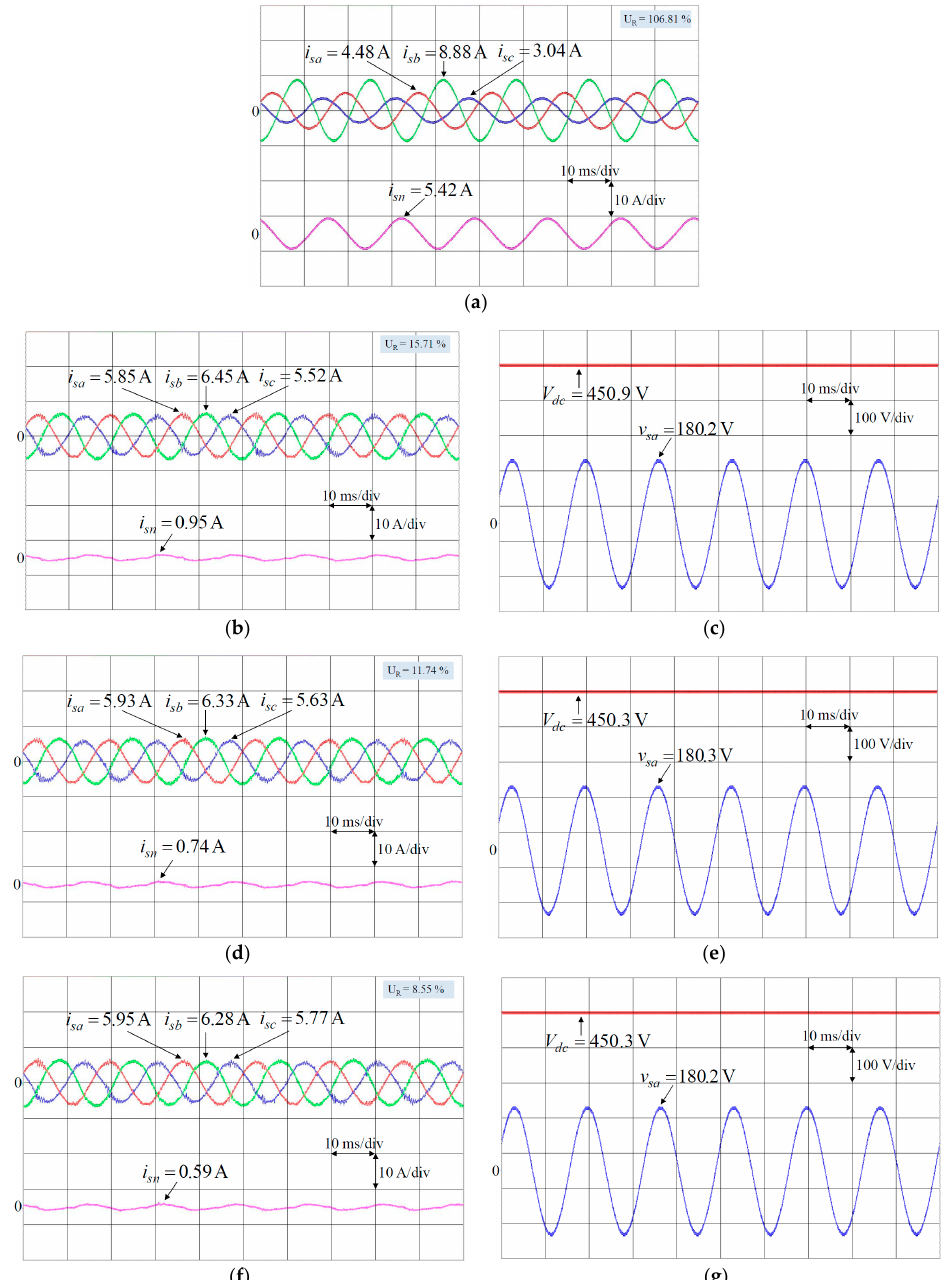
Figure 6. Experimental results at unbalanced load 2: ( a ) Responses of three-phase currents i sa , i sb , i sc and neutral current i sn without using shunt APF; ( b ) Responses of three-phase currents i sa , i sb , i sc and neutral current i sn using PI controlled shunt APF; ( c ) Responses of DC-link voltage V dc and phase voltage of power grid v sa using PI controlled shunt APF; ( d ) Responses of three-phase currents i sa , i sb , i sc and neutral current i sn using PFNN controlled shunt APF; ( e ) Responses of DC-link voltage V dc and phase voltage of power grid v sa using PFNN controlled shunt APF; ( f ) Responses of three-phase currents i sa , i sb , i sc and neutral current i sn using proposed PPFNN controlled shunt APF; and ( g ) Responses of DC-link voltage V dc and phase voltage of power grid v sa using proposed PPFNN controlled shunt APF.